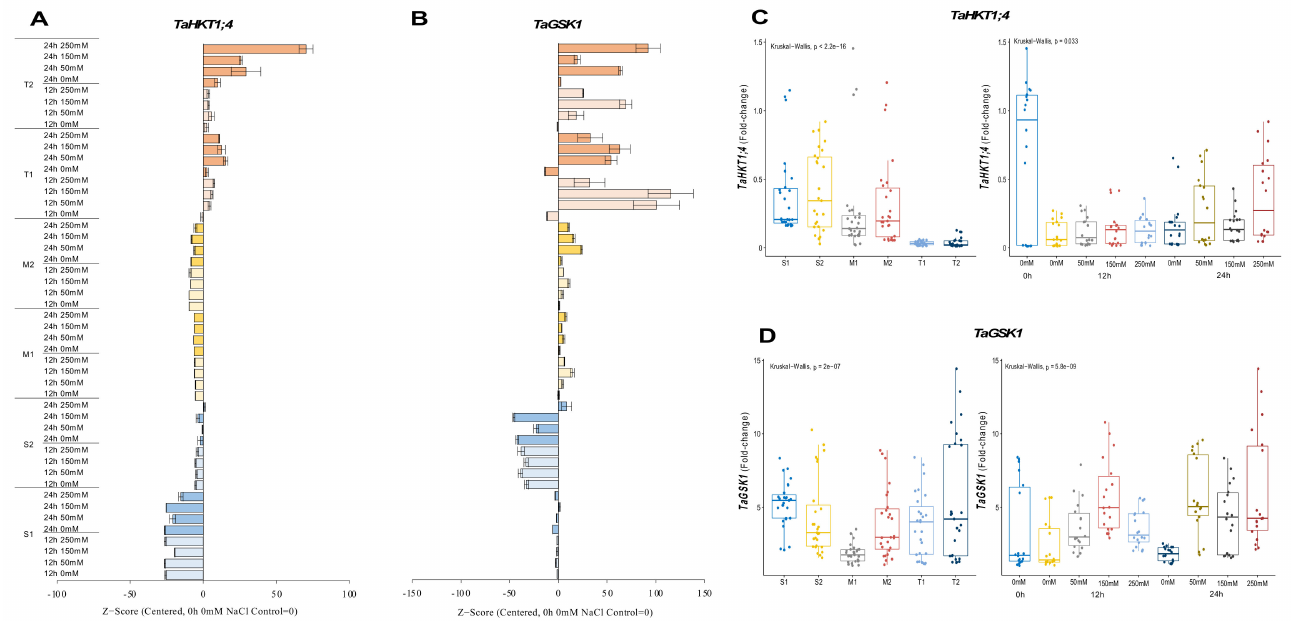
Figure 5. The expression of TaHKT1;4 and TaGSK1 genes. ( A ) The gene expression pattern of TaHKT1;4 and ( B ) TaGSK1 genes; ( C ) the total gene expression profile of TaP5CS for genotypes, salt stress, and time course; ( D ) the total gene expression profile of TaGSK1 for genotypes, salt stress, and time course. The Cq values formed the basis of qRT-PCR. The reference gene TaACTIN was used to standardize the Cq value for each sample. Z-score centered to 0 h 0 mM treatment (Control = 0). Values represent the means ± SD ( n =